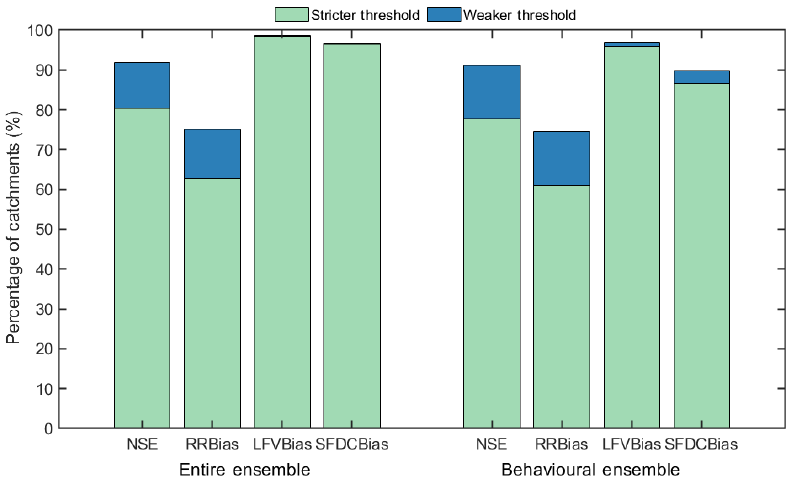
Figure 6. Percentage of catchments for each metric that meet the weaker and stricter performance thresholds for the entire ensemble of 10000 model simulations and from the top 1% behavioural ensemble of 100 model simulations generated from the combined ranking of the four metrics.